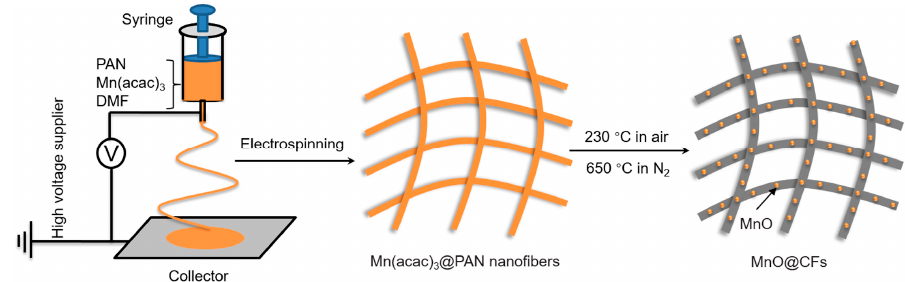
Figure 1. Schematic illustration of preparation of MnO nanoparticles anchored on carbon fibers